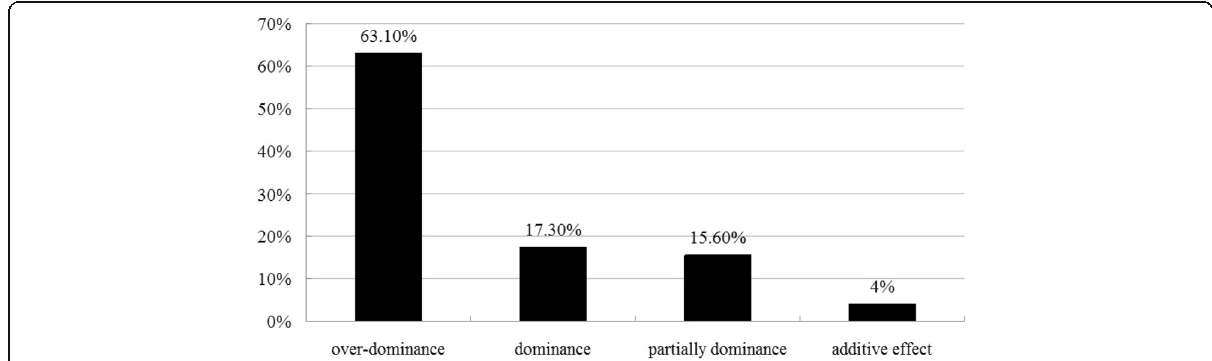
Fig. 5 Breakdown of the DGHP according to the dominance ratio Hp. Depending on the principal of Hp = [d] / [a], Hp was classified as either positive or